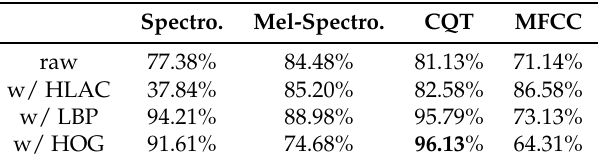
Table 1. ASC Results by using TFRs with local descriptors.